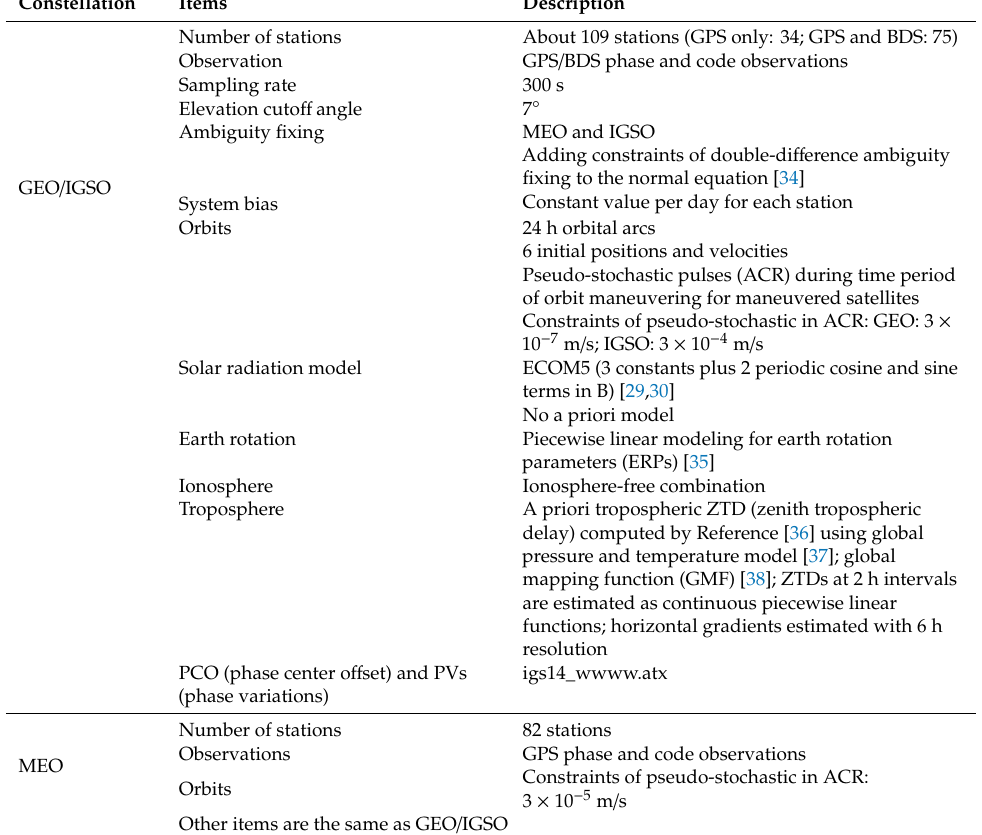
Table 1. Strategies of orbit determination (unit: meter). GPS, Global Positioning System; BDS, BeiDou Satellite System; MEO, medium earth orbit; IGSO, inclined geosynchronous orbit; ACR, radial, along-track, and across-track directions; GEO, geostationary earth